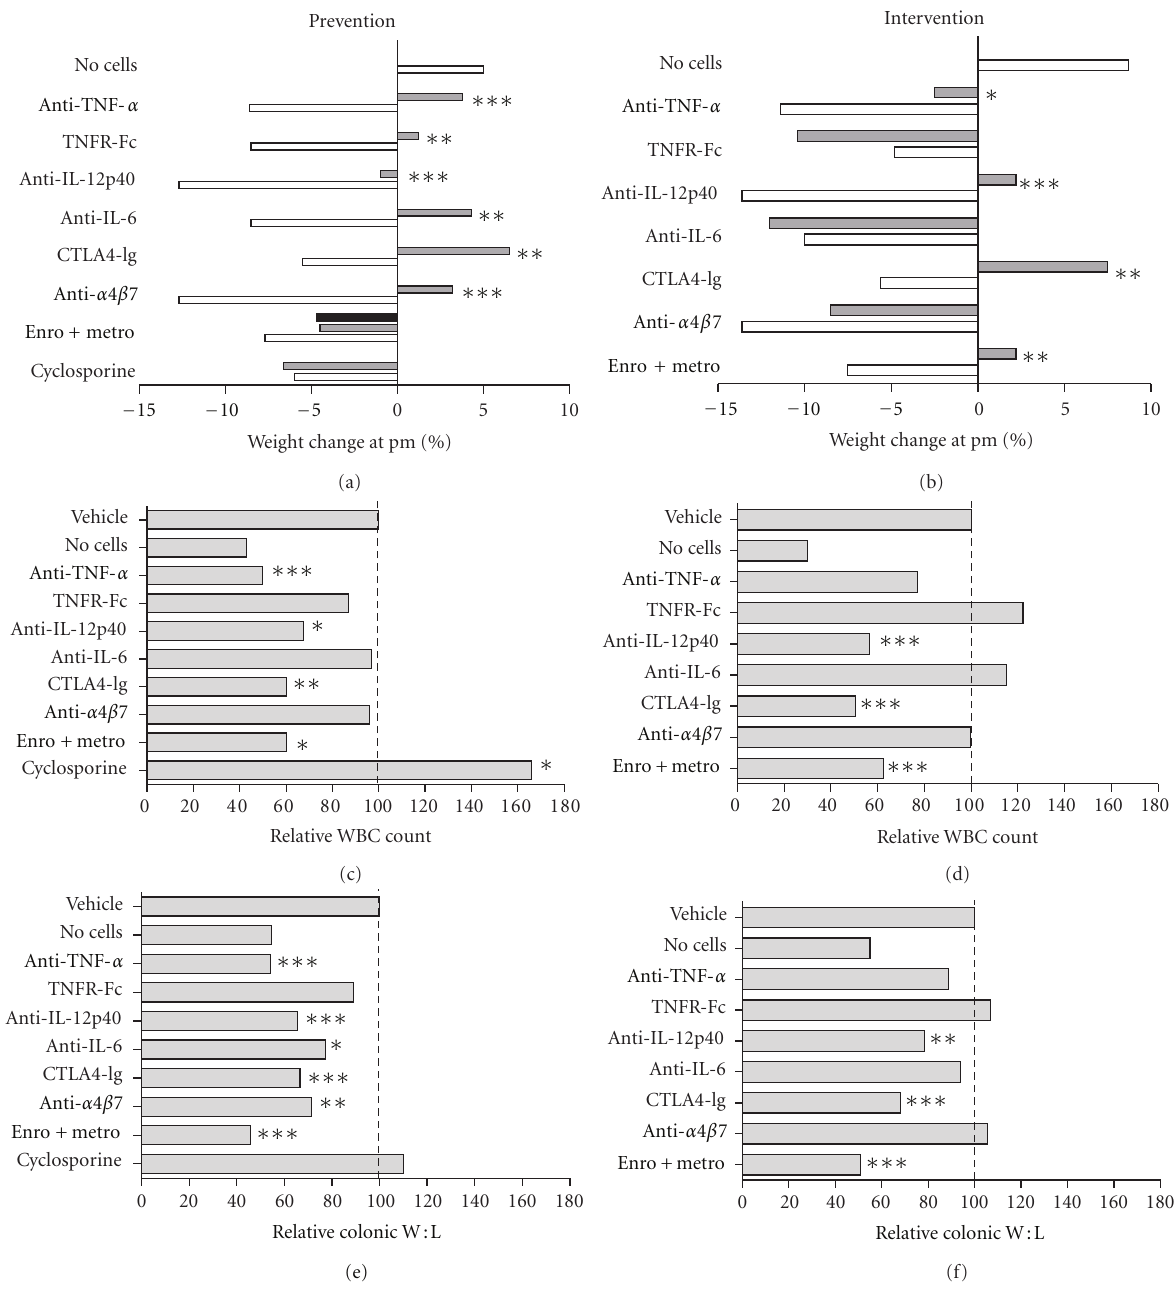
Figure 4: Changes in key disease parameters following treatment. Key disease parameters (weight loss, WBC counts, and colon W:L ratio) are depicted for preventive treatment (a–c) and interventive treatment (d–f). Disease parameters are shown as ((post mortem weight − start weight)/Start weight) ∗ 100, (WBC count of drug/WBC count of control) ∗ 100, (W:L ratio of drug/W:L ratio of control) ∗ 100. (a and d) White bars represent vehicle control groups, grey bars represent treatment groups, and black bars represent mice which were not reconstituted but received treatment. (b, c, e, and f) Grey bars represent relative WBC counts and W:L